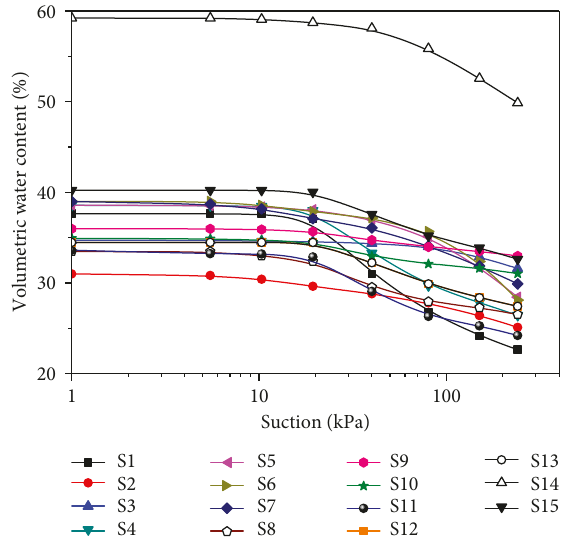
Figure 4: SWCCs of cohesive soils.